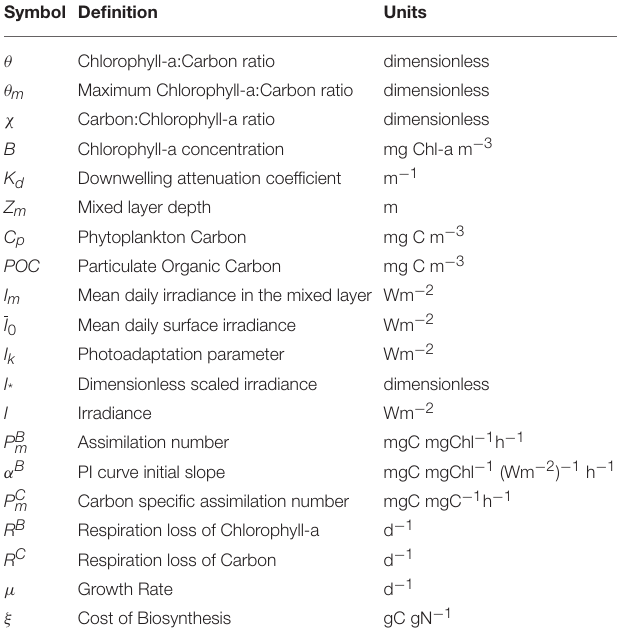
TABLE 1 | Definitions of